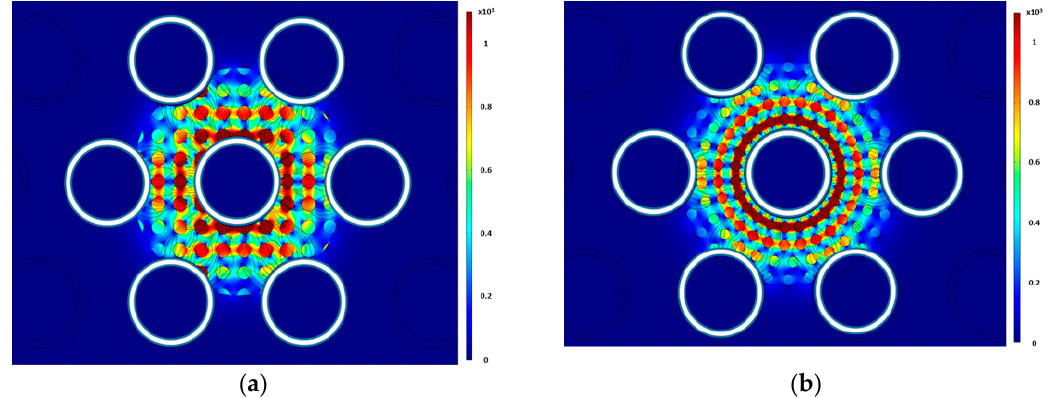
Figure 15. Electric field distribution for ( a ) Arrangement 1 and ( b ) Arrangement 2.